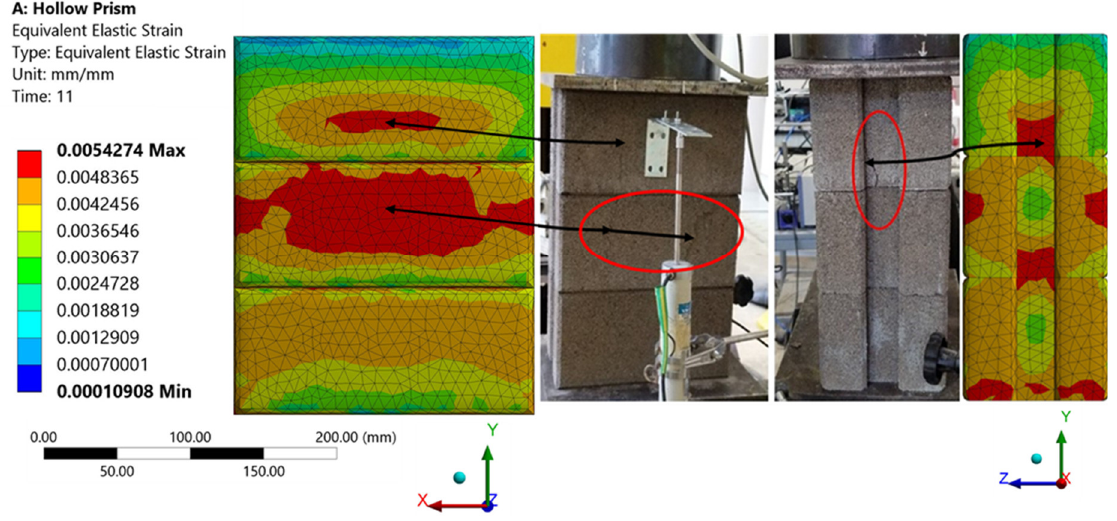
Figure 10. Failure mode (equivalent elastic strain) of hollow prism experimentally and FE model.